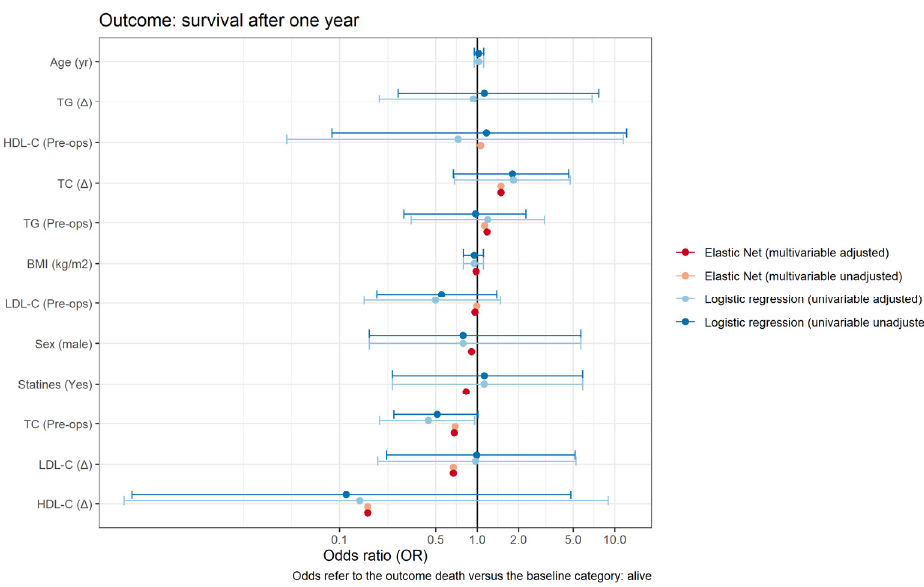
Figure 5. Forest plot showing the estimates of the odds ratio of various predictors on the outcome overall survival after one-year follow-up. For the logistic regression models, 95% confidence intervals are shown as well (adjusted values). No formal confidence intervals are computed for the elastic net regressions.